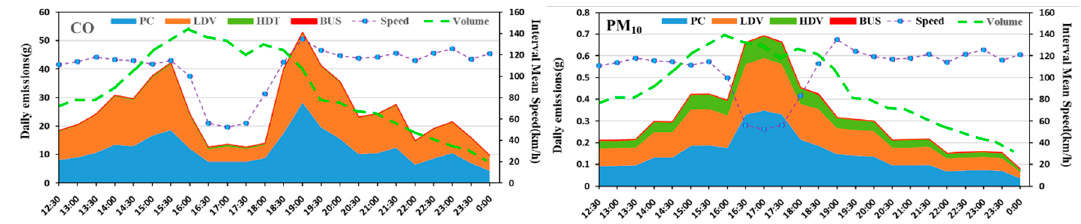
Figure 6. The relationship between CO and PM emissions with speed and traffic volume.